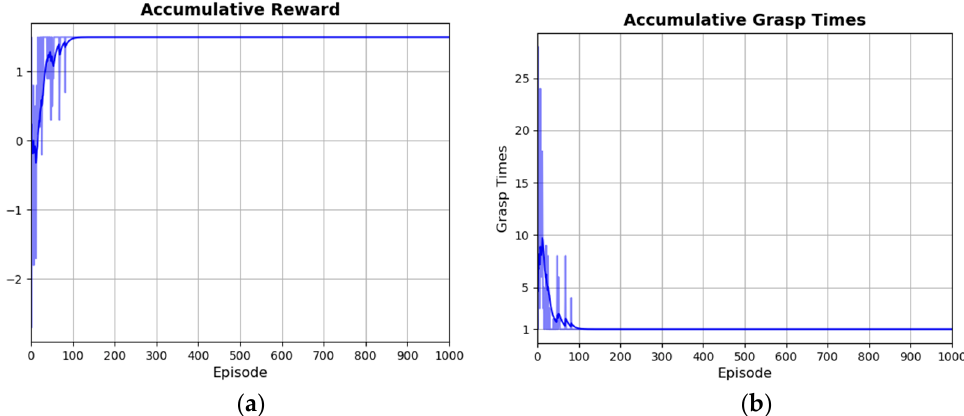
Figure 13. Training results of a fixed pose building block ( a ) accumulated reward for each episode ( b ) number of grasping attempts for each episode.